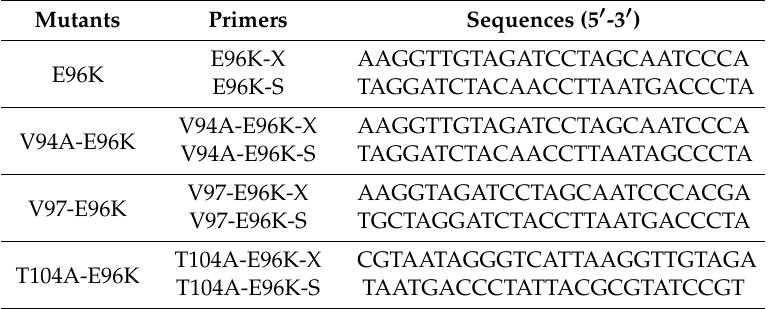
Table 1. Primers used in site directed mutagenesis with Glu to Lys substitution at residue 96 of Cucumber green mottle mosaic virus (CGMMV) coat protein (CP). Mutants